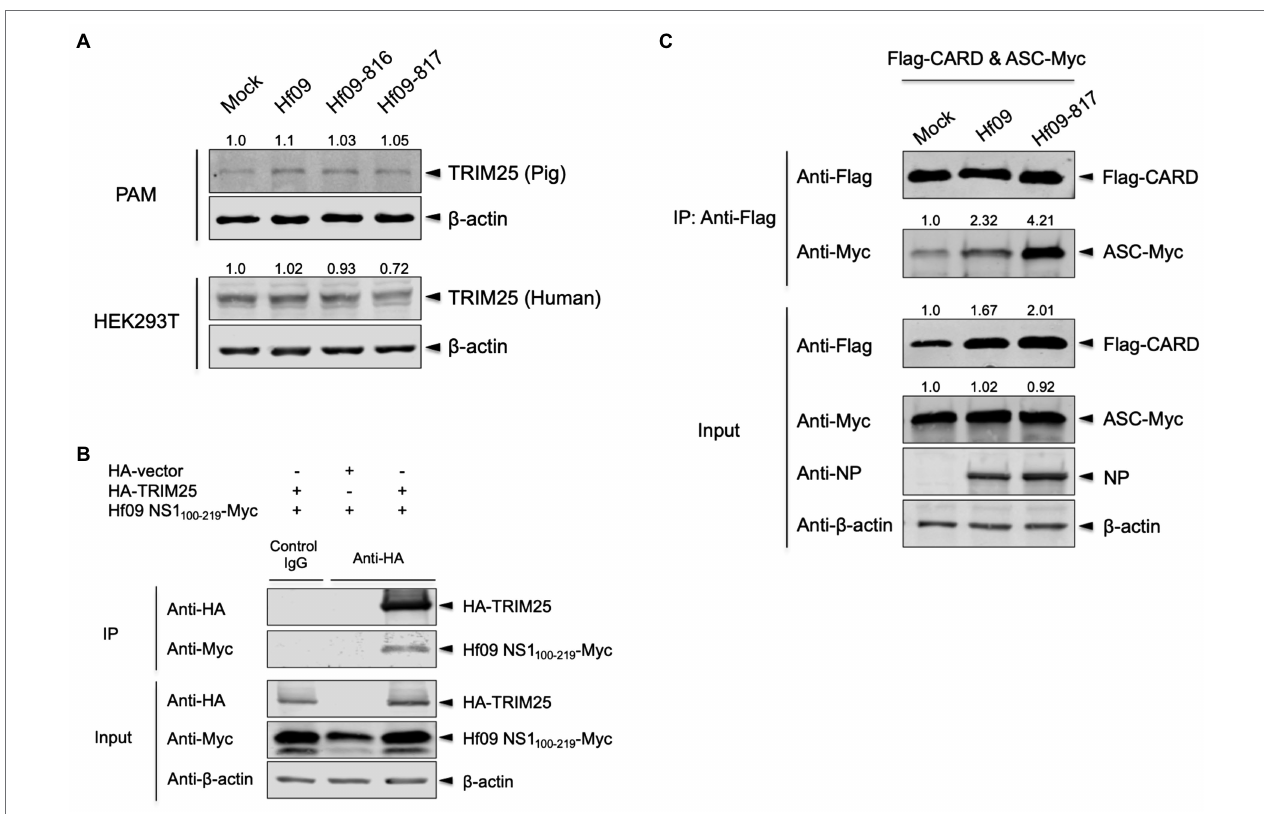
FIGURE 4 | NS1 C-terminus of 2009 pandemic IAV interacts with TRIM25 and inhibits the interaction between pro-caspase-1 and ASC. (A) PAMs or HEK293T cells were either mock-infected or infected with Hf09, Hf09-816, or Hf09-817 at an MOI of 5 for 16 h. The expression of endogenous porcine or human TRIM25 was analyzed by Western blotting. Relative intensities of TRIM25 to the mock condition were shown above each band. (B) HEK293T cells were transfected with an empty HA-vector or a plasmid expressing HA-tagged porcine TRIM25 along with a plasmid expressing Myc-tagged Hf09 NS1 C-terminus (aa 100–219) for 24 h. Cell lysates were subjected to IP with mouse IgG isotype control or anti-HA antibody. The expression of HA-tagged TRIM25 and Myc-tagged NS1 C-terminus in IP and input samples was analyzed by Western blotting using antibodies indicated. (C) HEK293T cells were transfected with plasmids expressing Flag-tagged porcine pro-caspase-1 CARD and Myc-tagged porcine ASC for 16 h, and then either mock-infected or infected with Hf09 or Hf09-817 at an MOI of 10 for 8 h. Cell lysates were subjected to IP with anti-Flag antibody. The expression of Flag-tagged CARD, Myc-tagged ASC, and viral NP in IP and input samples was analyzed by Western blotting using antibodies indicated. Relative intensities of ASC-Myc to the mock condition were shown above each band. Results are representative of three independent